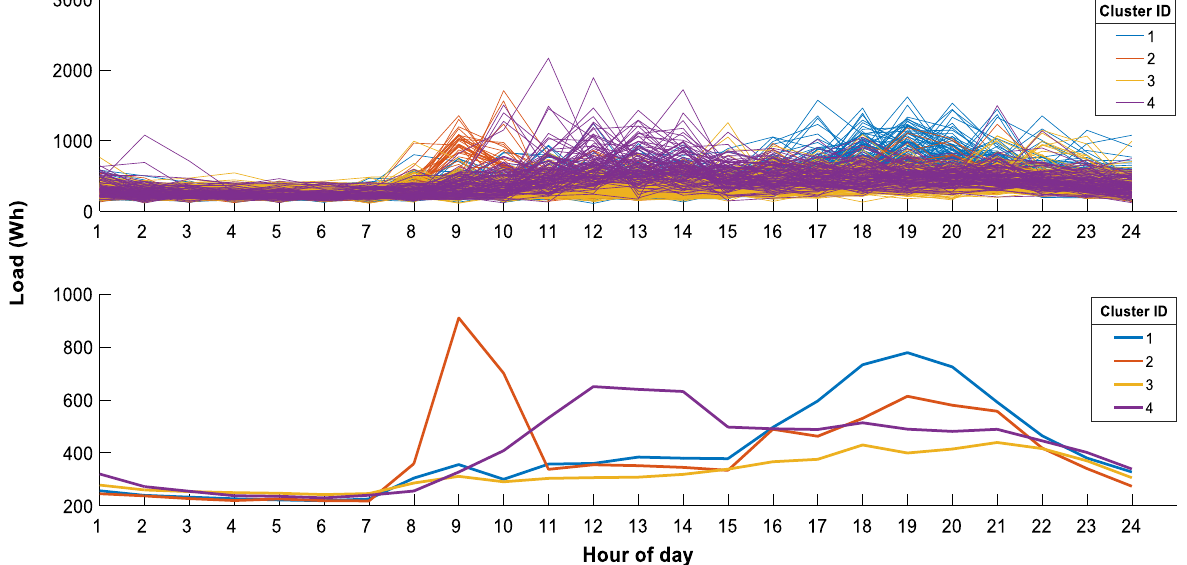
Fig. 7. Clustering assignment and cluster centroids for the Household 1.